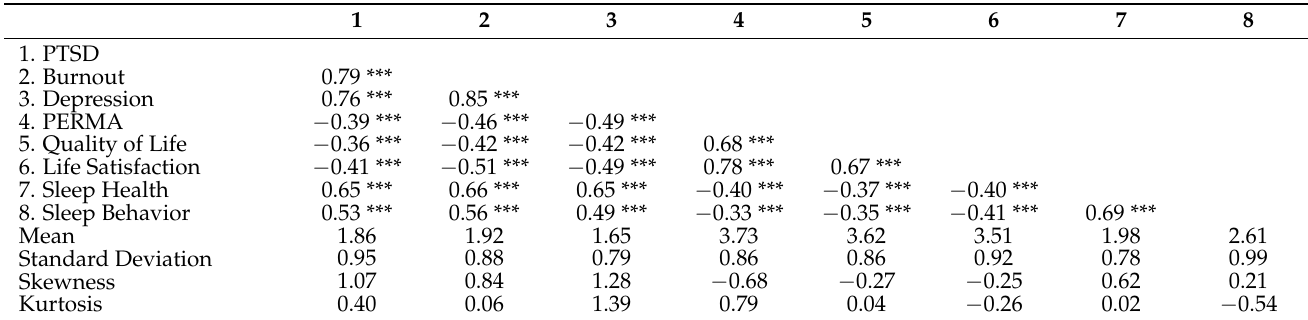
Table 3. Correlations among variables ( N =